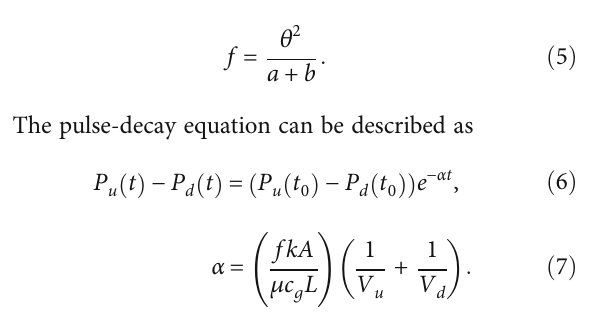
at 296 K. Mostly, the fl ow is lying in the transition fl ow and slip fl ow region. 2